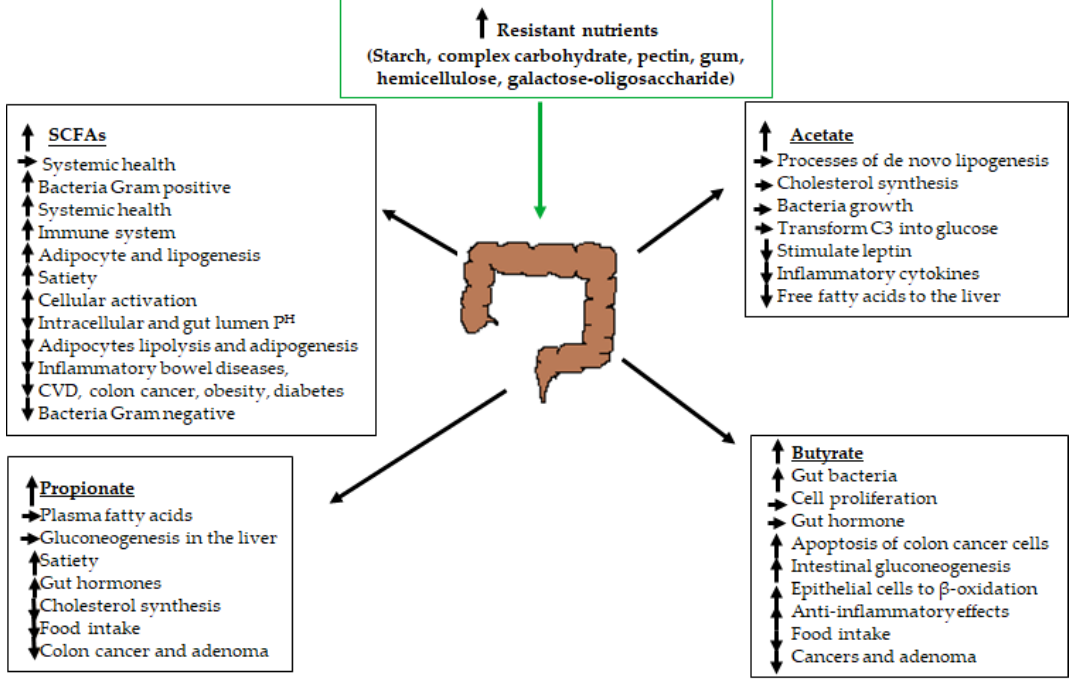
Figure 1. The role of the gut microbiota in short-chain fatty acid (SCFA) production and their benefits to human physiology regulation, which have contributed greatly in health promotion and disease prevention. Abbreviation: ↑ = significant increase; ↓ = significant decrease; → = stable performance C3 = propionate; and CVD = cardiovascular diseases.